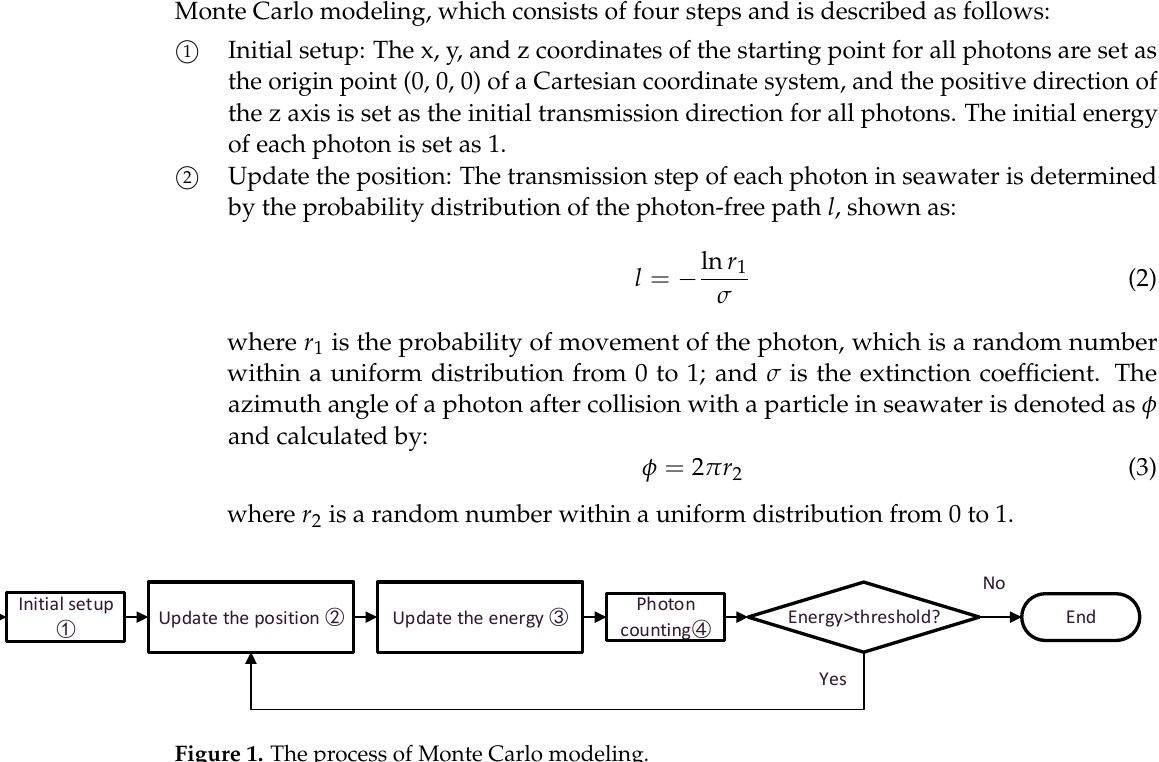
Figure 1. The process of Monte Carlo modeling. Initial setup: The x, y, and z coordinates of the starting point for all photons are set